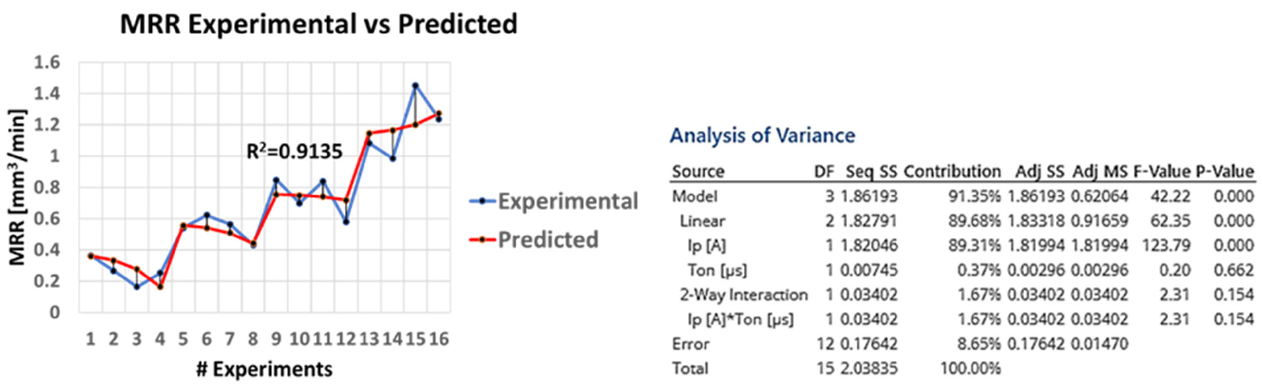
Figure 4. Plot of experimental MRR vs predicted MRR along with model’s ANOVA .